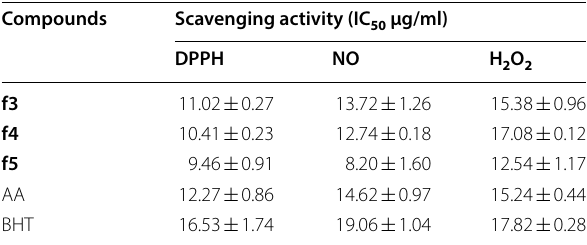
Lower IC 50 values indicate higher radical scavenging activity AA ascorbic acid, BHT butylated hydroxy toluene